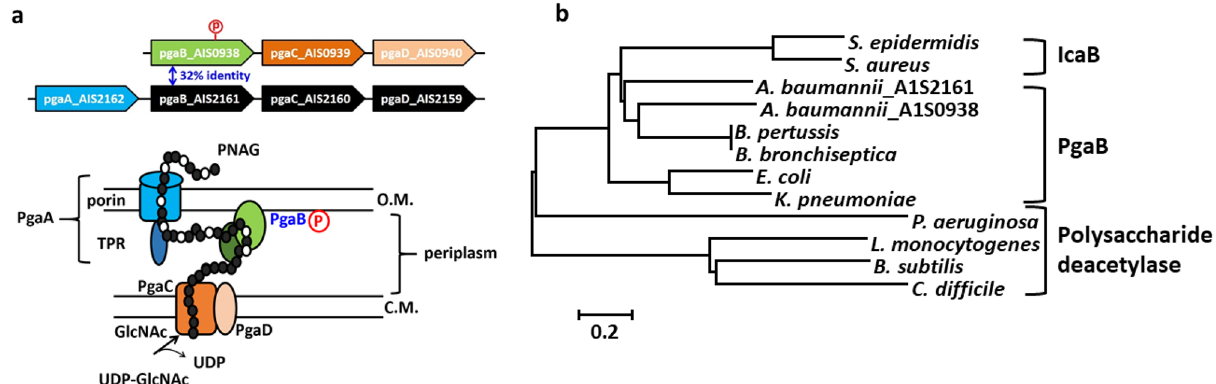
Figure 1. Schematic illustration of two PNAG synthesis operons in A. baumannii . ( a ) The coding genes A1S- 0938 to A1S-0940 and A1S-2162 to A1S-2159 were annotated as PNAG synthesis operons in A. baumannii . PgaC (brown) and PgaD (orange) Protein complexes were located on the cytoplasmic membrane to polymerize N -acetylglucosamine. PgaB is a PNAG deacetylase that anchors on the outer membrane and is located at the periplasm. Outer membrane transporter protein PgaA contributed to the transport of partially deacetylated PNAG as an exopolysaccharide. ( b ) Phylogenetic analysis of polysaccharide deacetylases in CE4 family of CAZy database from bacteria based on Neighbor Joining clustering